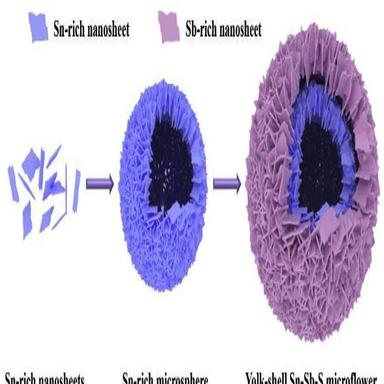
Schematic illustration of the synthetic process for yolk-shell Sn-Sb-S microflower composite.